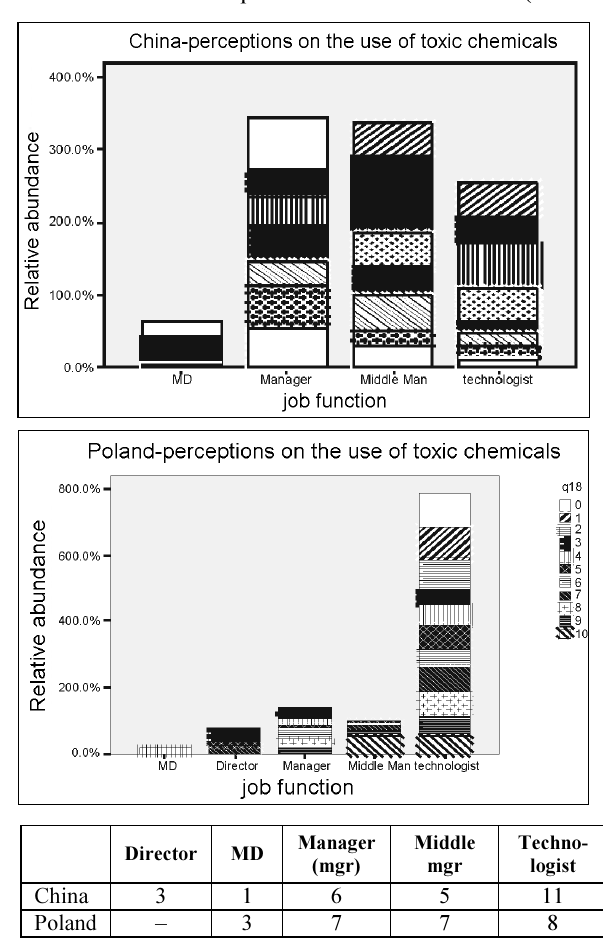
Fig. 2. Numbers of the fragmentation of perceptions down the management